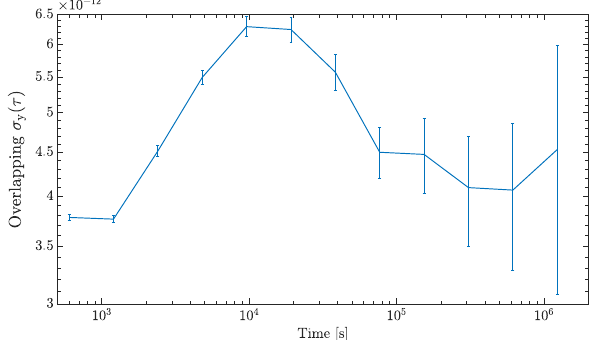
Fig. 1 The evaluated Sagnac frequency ω s /( 2 π)